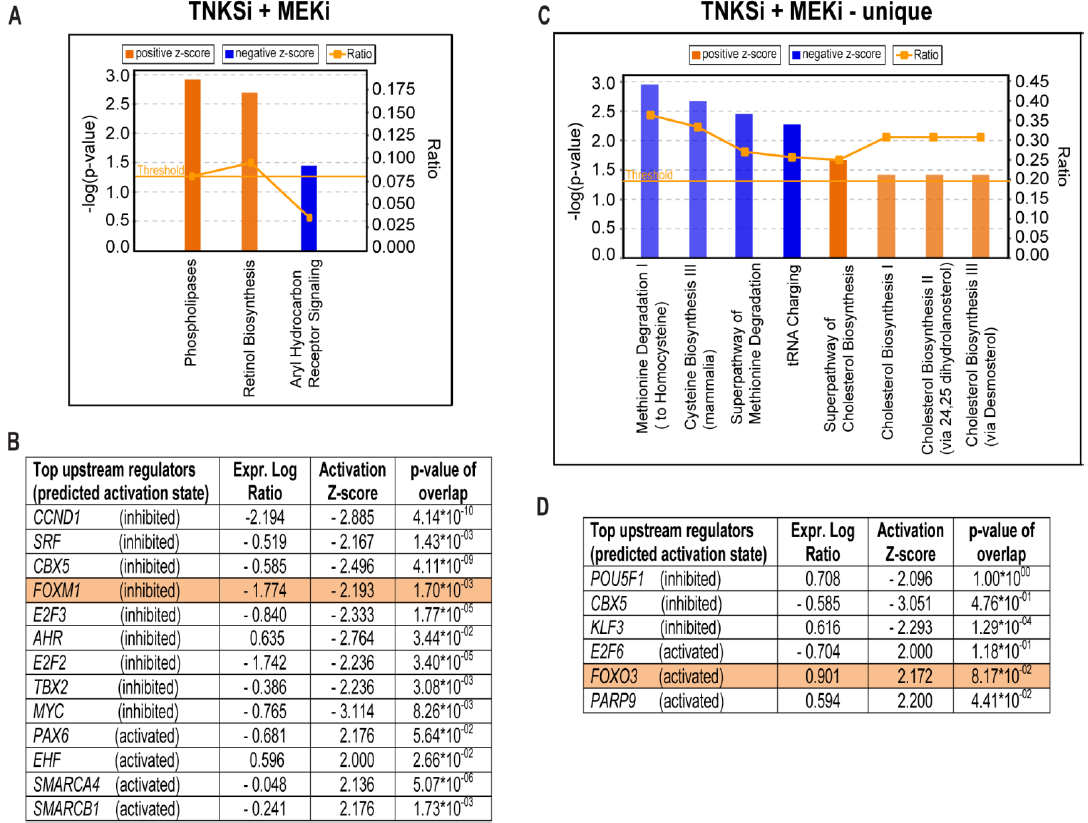
Figure 5. Combined TNKSi/MEKi treatment induces a positive FOXO3 / FOXM1 ratio. The IPA software core analysis (lfc > ± 2, padj < 0.01 [data input], z -score > ± 2 [analysis output]) was used to